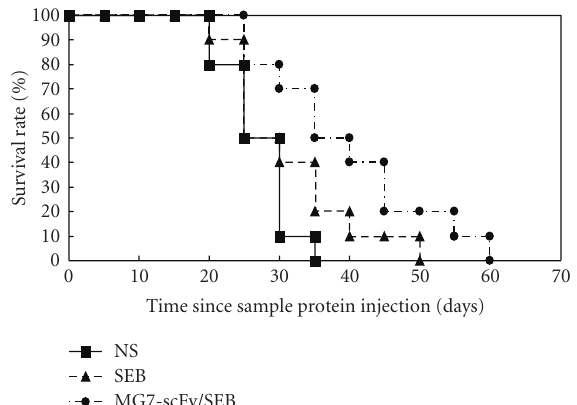
Figure 8: Ten gastric-cancer-bearing rats in each group were observed for their survival time after being administrated with MG7-scFv/SEB, SEB, or NS. The survival times of the rats in MG7-scFv/SEB and SEB group were longer than that of NS group within 60-day observation ( P < . 05). There were statistic di ff erences among the three groups ( P < .